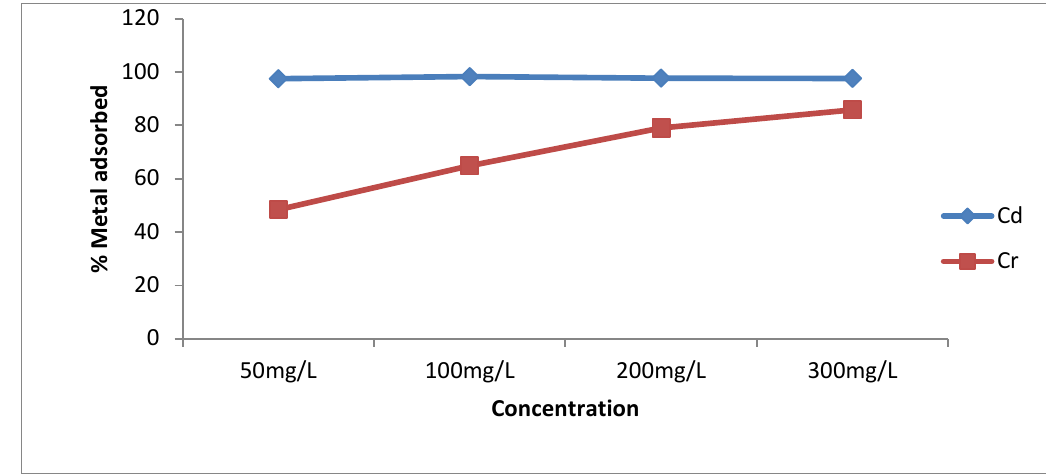
Figure 5: Effect of Concentration on the removal of Cd and Cr aqueous solution